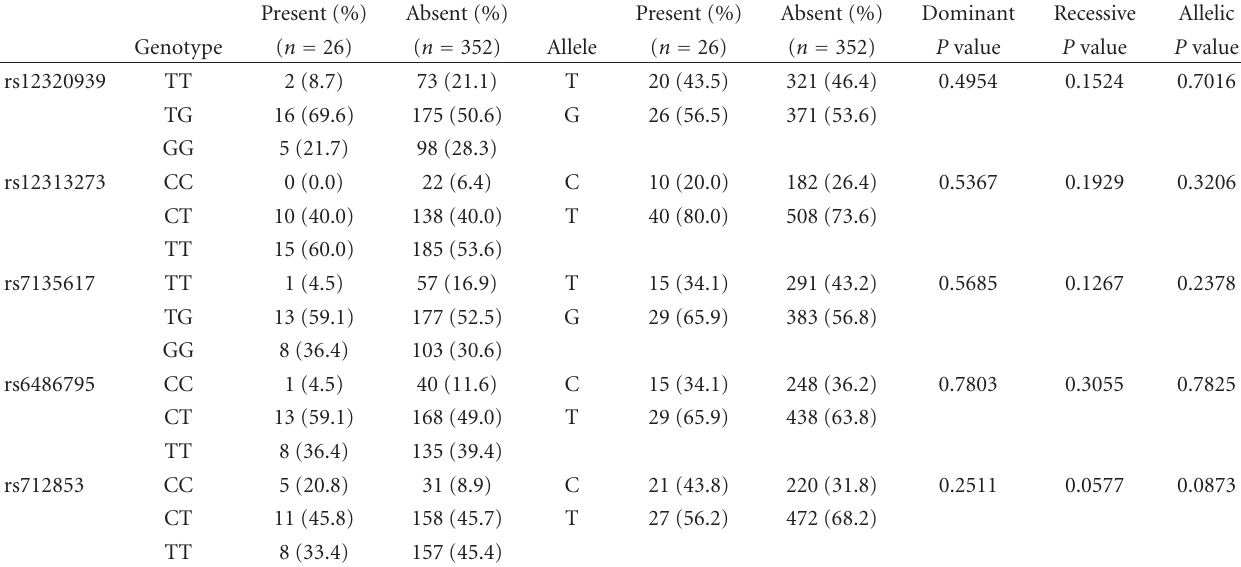
Table 1: Genotyping and allele frequency of ORAI1 gene in patients with breast cancer with or without recurrence.